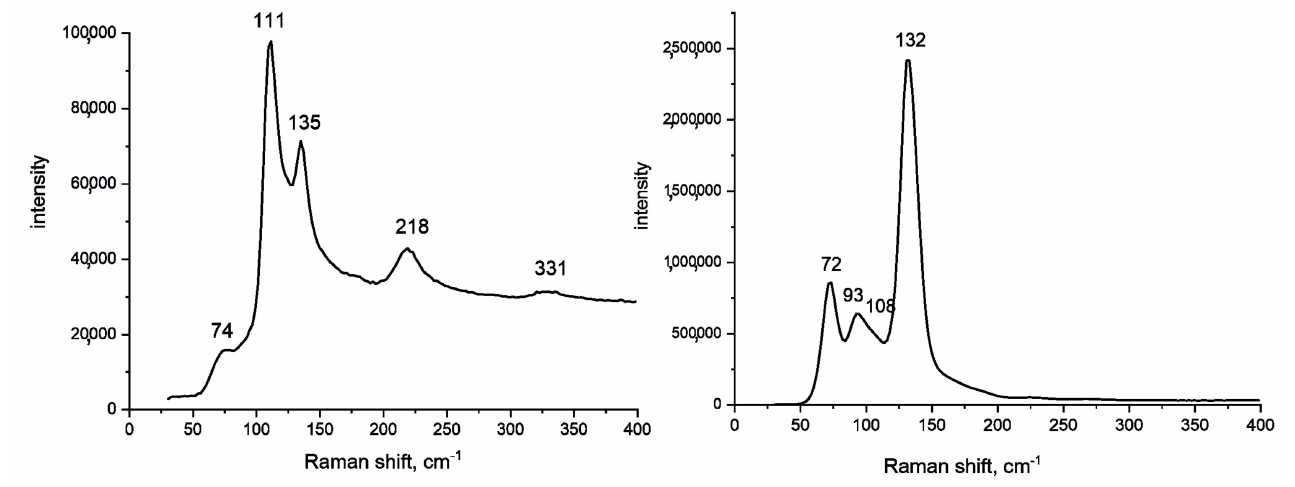
Figure 3. Raman spectra of 1 ( left ) and 2 ( right